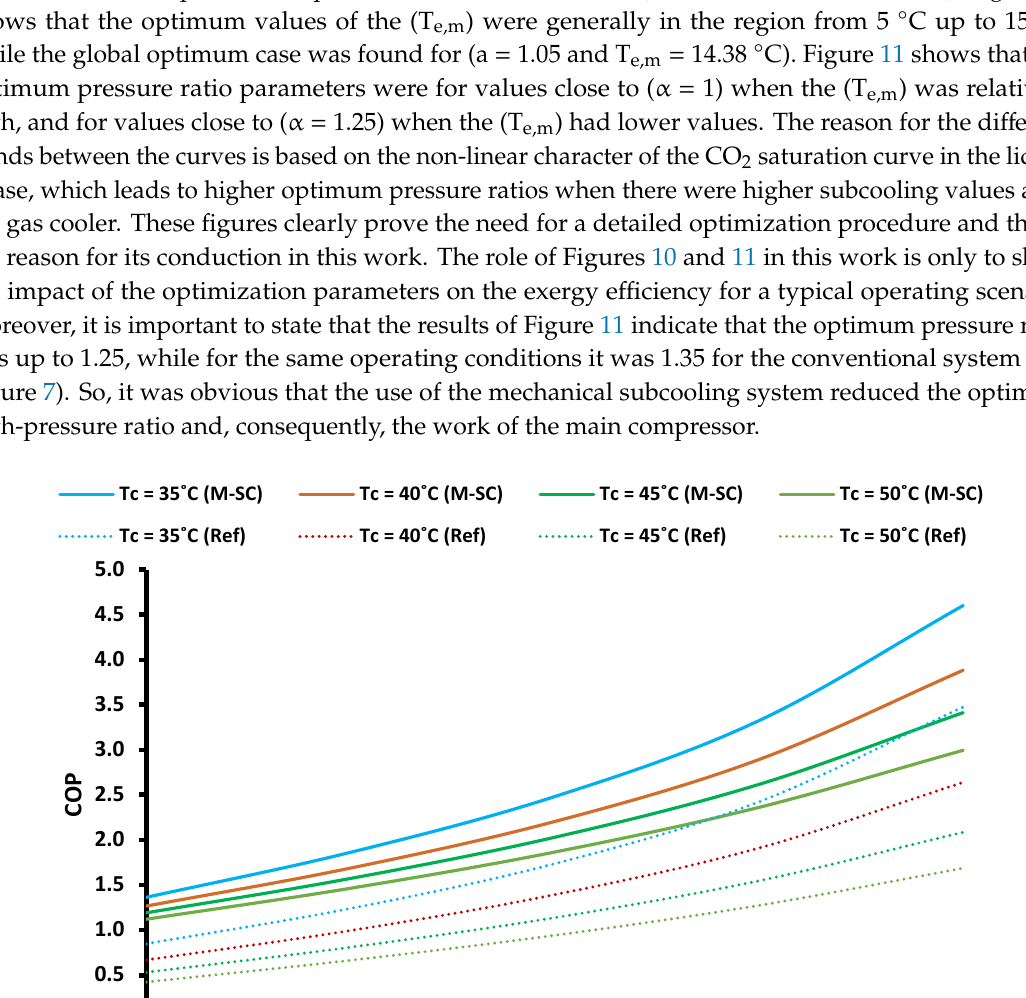
0.00.51.01.52.02.53.03.54.0 Figure 8. The COP of the mechanical subcooling system compared to the reference case for all the examined optimized scenarios. Figure 9. The exergy efficiency of the mechanical subcooling system compared to the reference case for all the examined optimized scenarios.